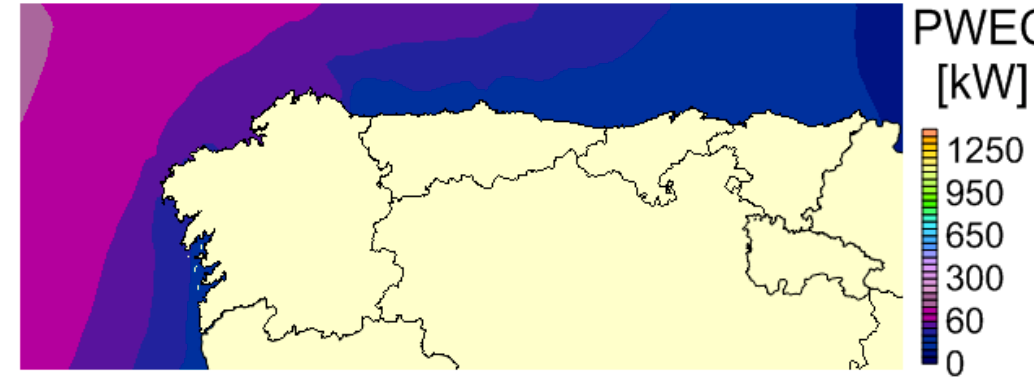
Figure 7. Power of Pelamis.